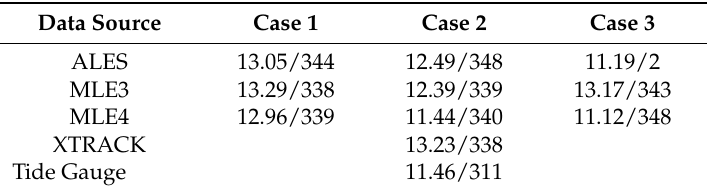
Table 4. Estimated annual amplitude (cm) and phase (degree) as a function of sea level data source and case.